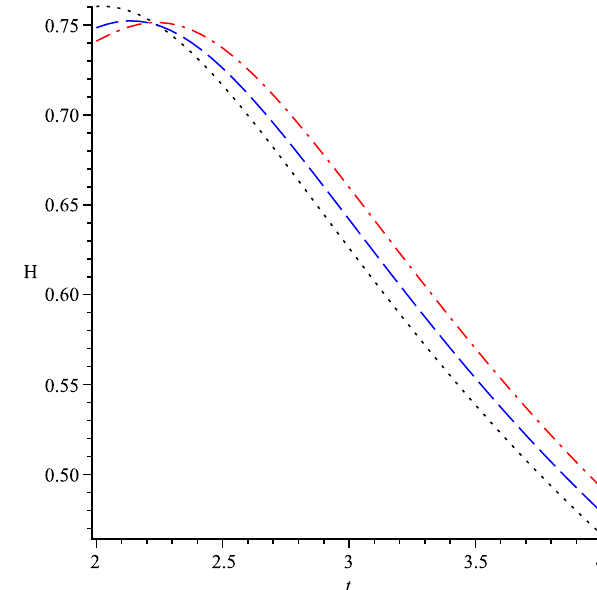
Fig. 1 Graphical representation of variation of the scale factor a vs t for γ = 1